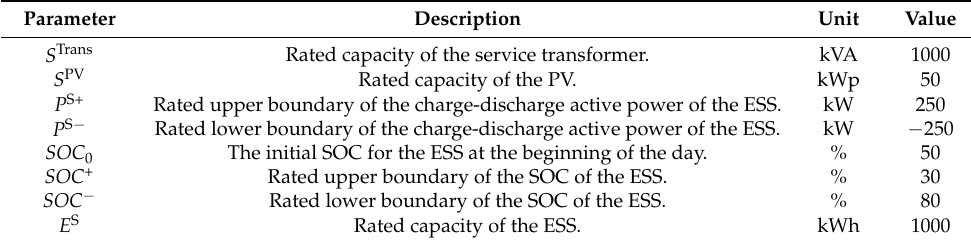
Table 1. The basic configuration.